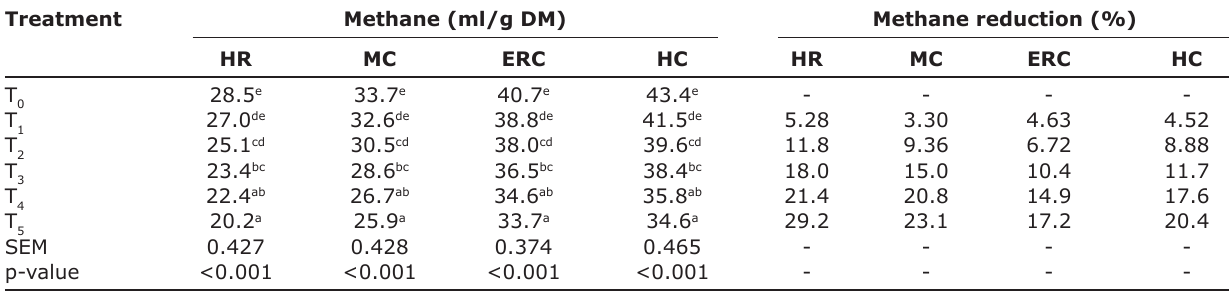
=Silkworm pupae oil supplementation at 2% of basal 3 diet, T =Silkworm pupae oil supplementation at 4% of 4 basal diet and T =Silkworm pupae oil supplementation 5 at 5% of basal diet. SEM=Standard error of mean, Mean values bearing different superscripts in a column differ significantly Table-5: Effect of silkworm pupae oil supplementation at graded levels with different dietary regimes on methane production. Treatment